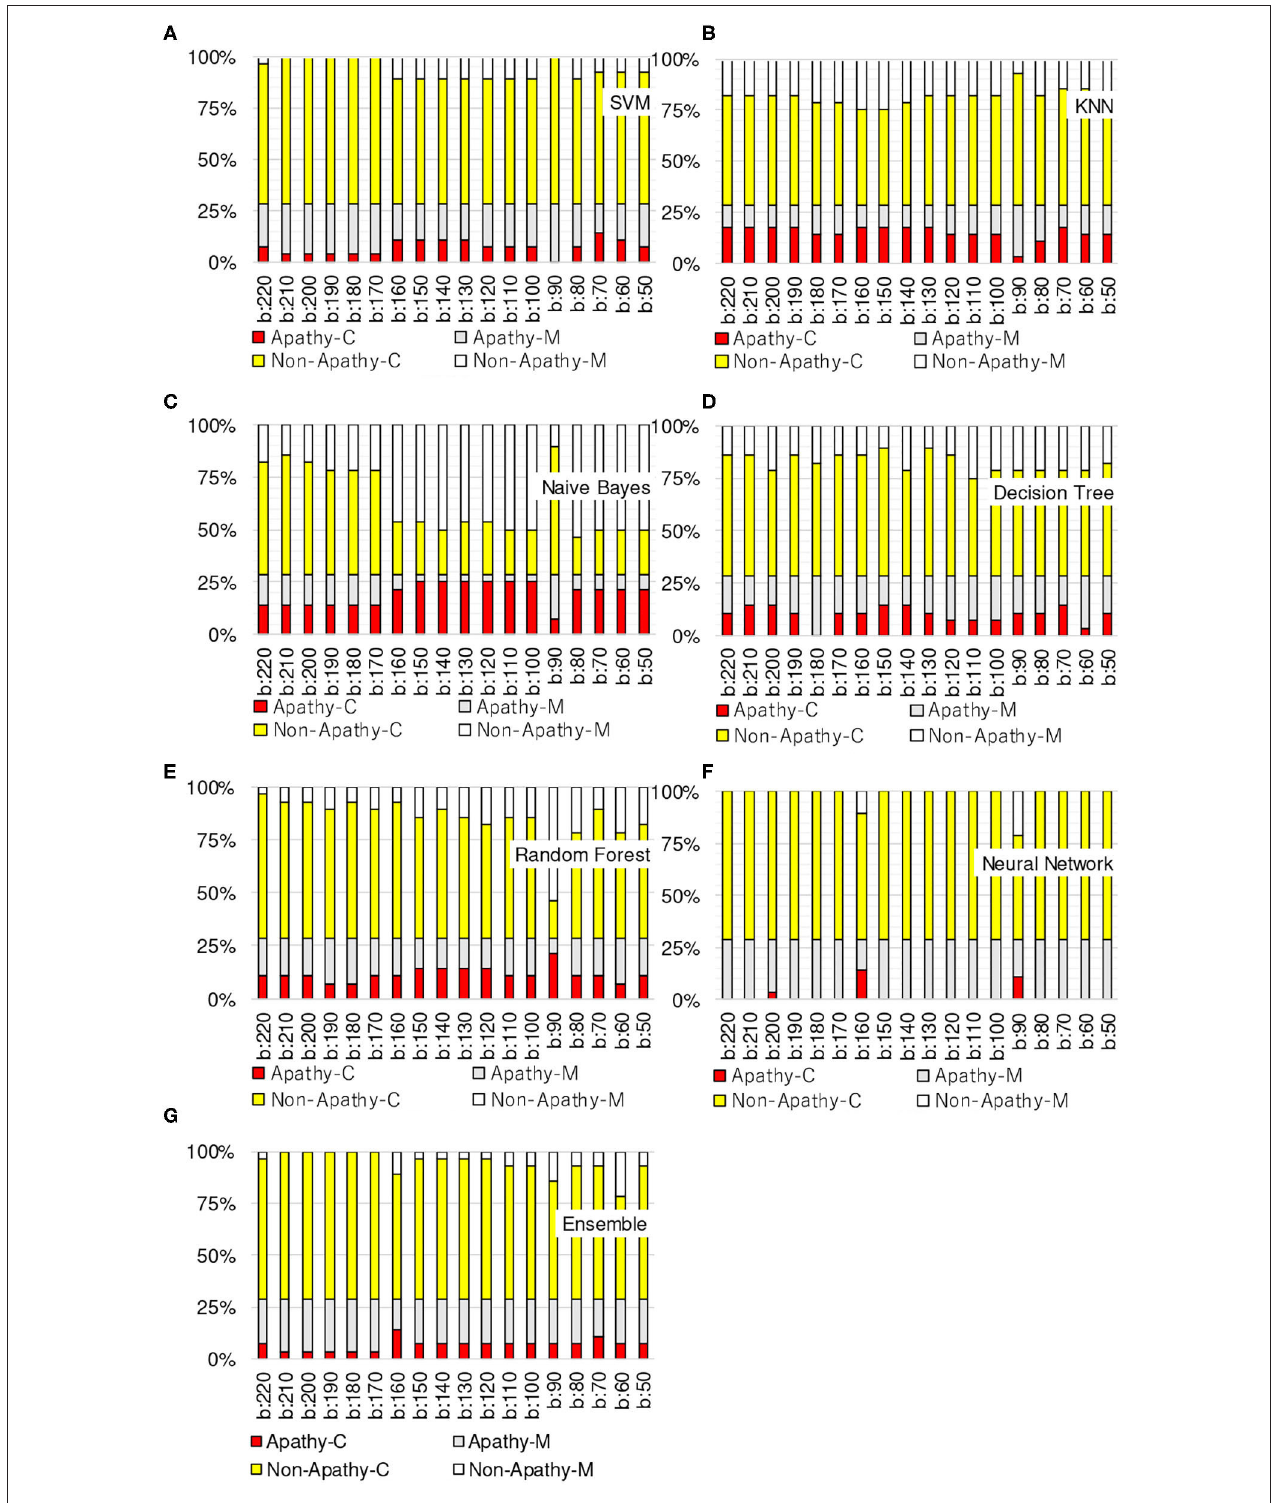
FIGURE 5 | Experimental results: using blue channel. (A) SVM, (B) KNN, (C) Naive Bayes, (D) decision tree, (E) random forest, (F) neural network, (G) ensemble.